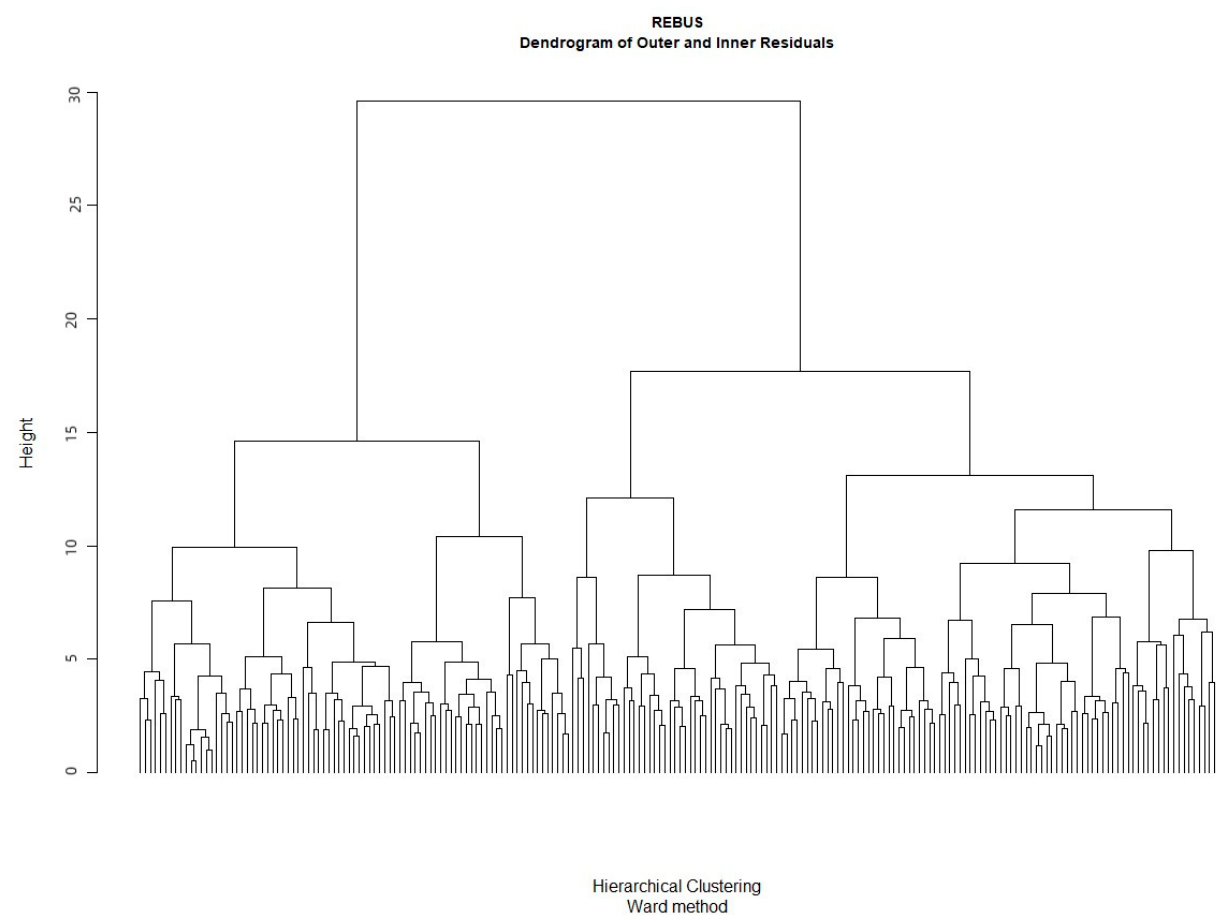
Figure 2. Dendogram obtained by cluster analysis on the residuals from the global model. Class 1 ( n = 71): The path coefficients from monetary rewardability (utilitarian af- fordance), playfulness (hedonic affordance), and connectiveness (social affordance) to immersion reflected significant effects. The strongest effect on immersion was from mone- tary rewardability ( β = 0.428). In this class, contrary to the global model, connectiveness had a very strong and significant effect on immersion, with a path coefficient of 0.306 and p -value < 0.05. However, in this class, novelty affordance had no impact on immersion. The link between immersion and purchase intention was strong, with β = 0.702. Since in this class only the effect of novelty affordance was insignificant, the respondents in this class were labeled “no novelty” users. For class 1 the path link between connectiveness and immersion showed a regression coefficient of 0.306, which was greater than those obtained for the second and third classes. For class 1, the GOF and R 2 (purchase intension) values were 0.575 and 0.493, respectively, which were greater than those for the global model. Class 2 ( n = 69): The second class was characterized by significant path coeffi- cients between all affordances and immersion except playfulness. Playfulness affordance, in this class, had an insignificant relationship with immersion. However, similar to the other two classes, in this class the path between monetary rewardability affordance and immersion was the strongest among all affordances. Thus, immersion in this class was driven by the absence of playfulness elements. We labeled the respondents in this class as “no playfulness” users. It is also interesting to note that the path coefficient between immer- sion and purchase intention for this class ( β = 0.926) was strongest among all the classes, as well as stronger than the global model. The GOF value for this class (0.738) was greater than for the global model, which was a prerequisite for a class to be considered